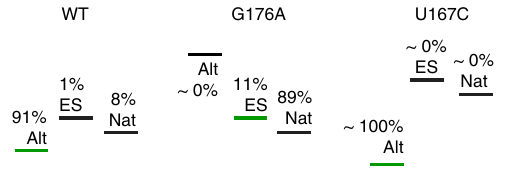
NATURE COMMUNICATIONS|7:11768|DOI: